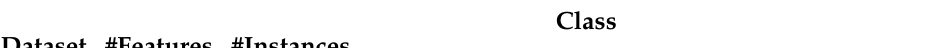
Table 2. Details of student evaluation datasets.